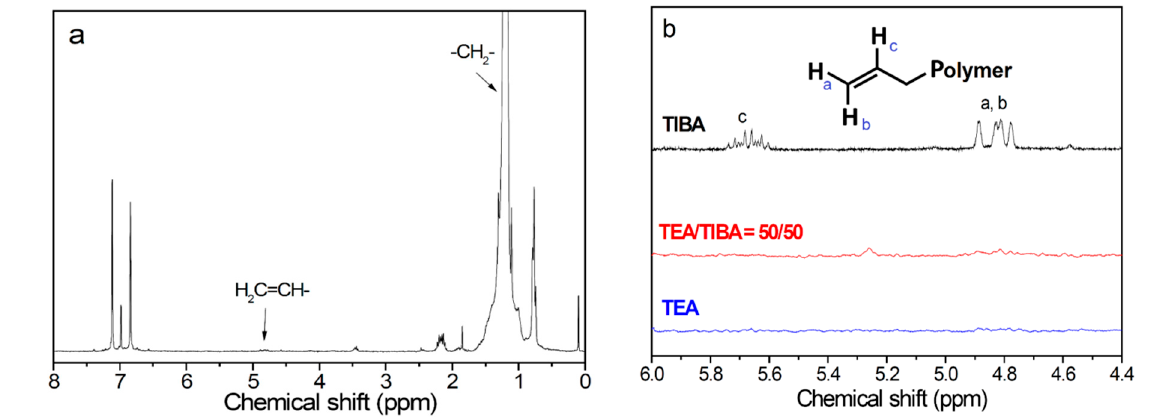
Figure 3. 1 H NMR spectra of polyethylene ((see supporting information) ( a ). Run 1.1, 1.3, 1.5 in Table S1, ( b ). Runs 2.1, 2.3 and 2.5 in Table S1).